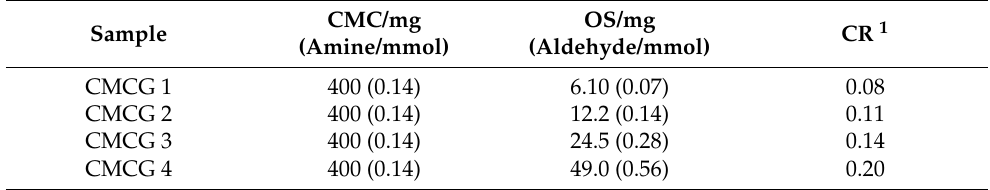
Figure 4. Quantitative 13 C NMR spectrum of CMC used for preparation of CMCG (298 K, D 2 O). Resonance assignments are also indicated. The numbers 2s, 3s, and 6s represent the resonance lines at the positions substituted by the carboxymethyl groups. O -CM and N -CM refer to the carbonyl carbon resonances of the carboxymethyl groups substituted at the hydroxyl and amine groups of chitosan, respectively. Table 2. Initial feed amounts of carboxymethyl chitosan (CMC) and oxidized sucrose (OS) for preparation of the CMG hydrogels (CMCG 1–4). The cross-linking degrees (CR) of the hydrogels are also